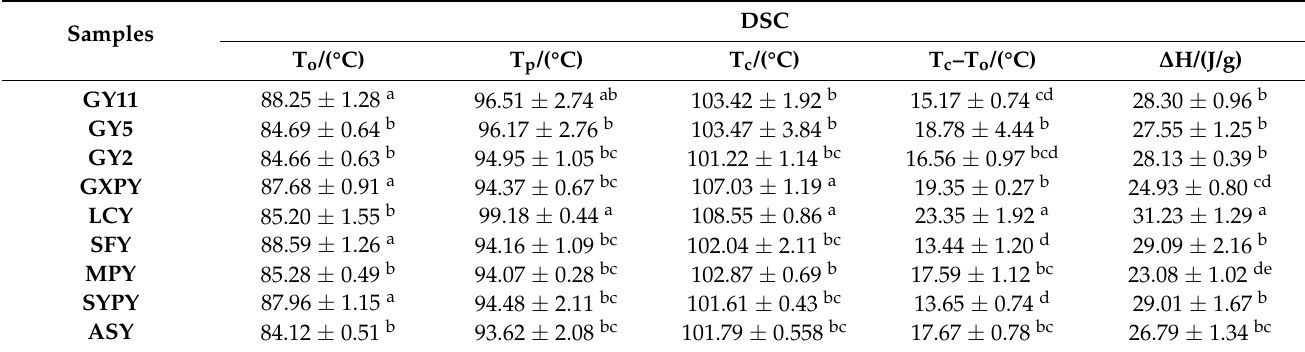
Table 3. The thermal properties of yam